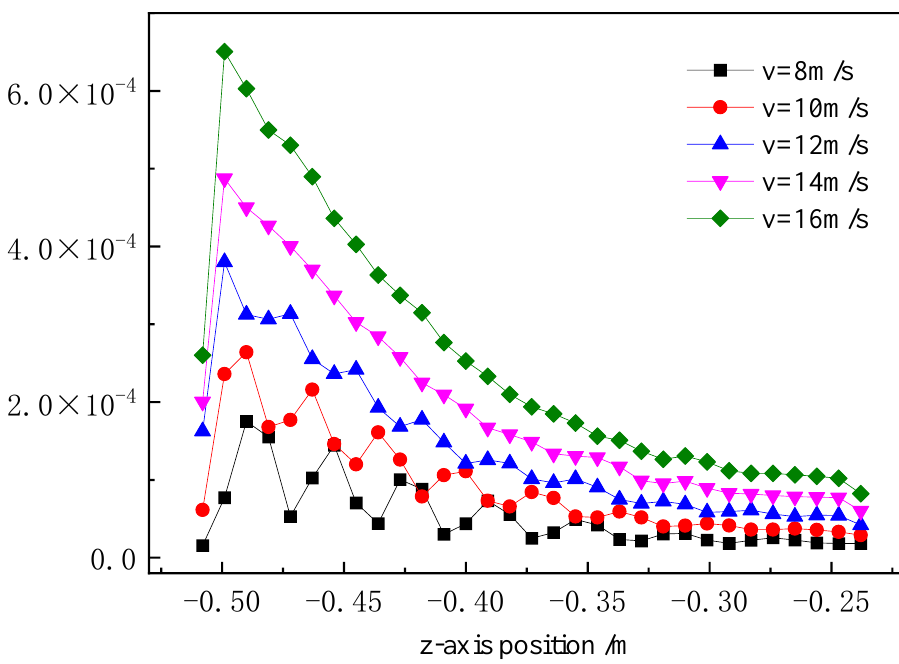
Figure 12. Erosion rate for different cone velocities.